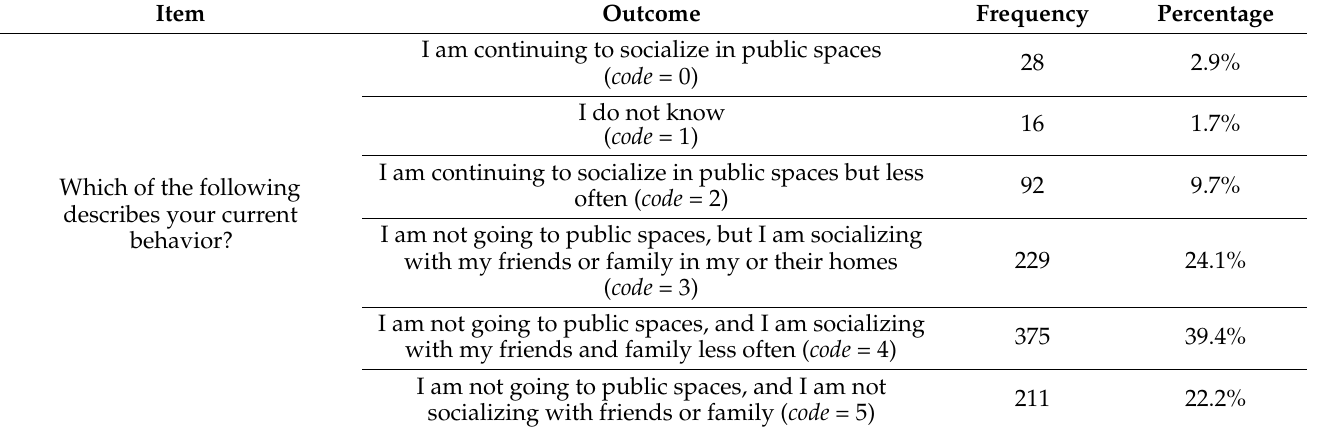
Table 5. Responses of the participating Palestinian students to the COVID-19-related practices.subscale, May 2020 ( n = 951). Item Outcome